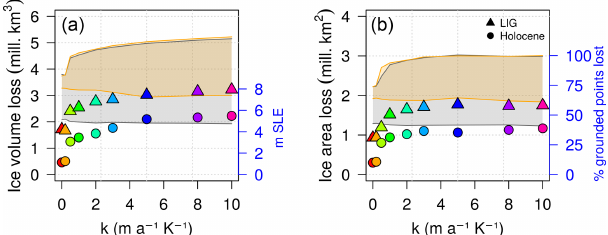
Figure 8. Distribution of ice volume (a) and area (b) lost during the LIG and the Holocene as a function of κ , for B ref = 1ma − 1 . Grey and yellow shades show the deviation between the maximum and the minimum ice volumes (area) for LIG and Holocene, re- spectively (see Fig. 5). The loss is calculated between the time at which the ice volume reaches its maximum value simulated before deglaciation (between 140 and 128kaBP for TII and between 19 and 10kaBP for TI) and the subsequent ice minimum (between 122 and 121kaBP for the Eemian and between 8 and 0kaBP for the Holocene). The colours of the points follow the legend of Fig. 5 for clarity.